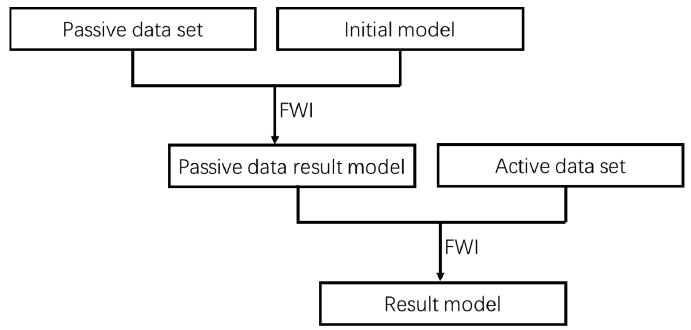
Figure 4. Multisource FWI workflow.